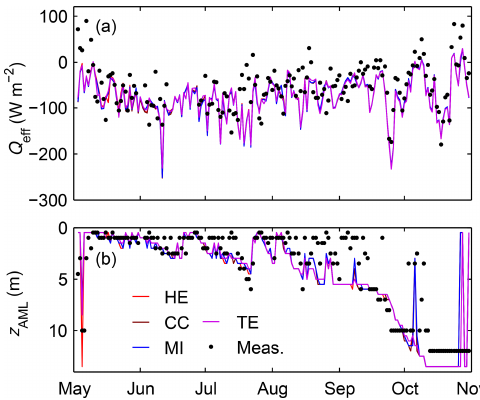
Figure 2. (a) Daily effective surface heat fluxes (Wm − 2 ) simulated with each GEM and calculated on the basis of heat flux measure- ments. (b) Simulated and empirically determined depths of the daily actively mixing layer (m) in Lake Kuivajärvi in May–October